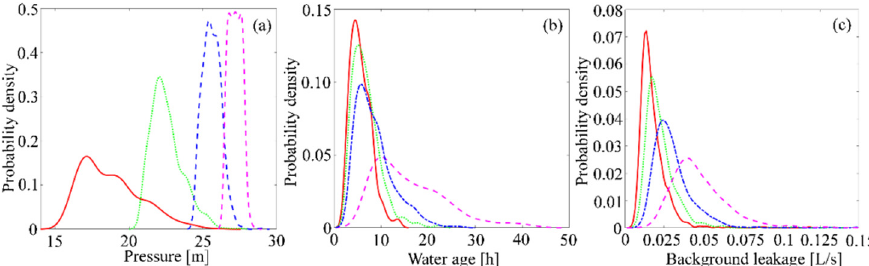
Figure 8. Probability density distributions of the three key indicators for the four solutions: ( a ) nodal pressure, ( b ) water age, and ( c ) background leakage. (The red, green, blue and purple lines represent solution 1, solution 2, solution 3 and solution 4,